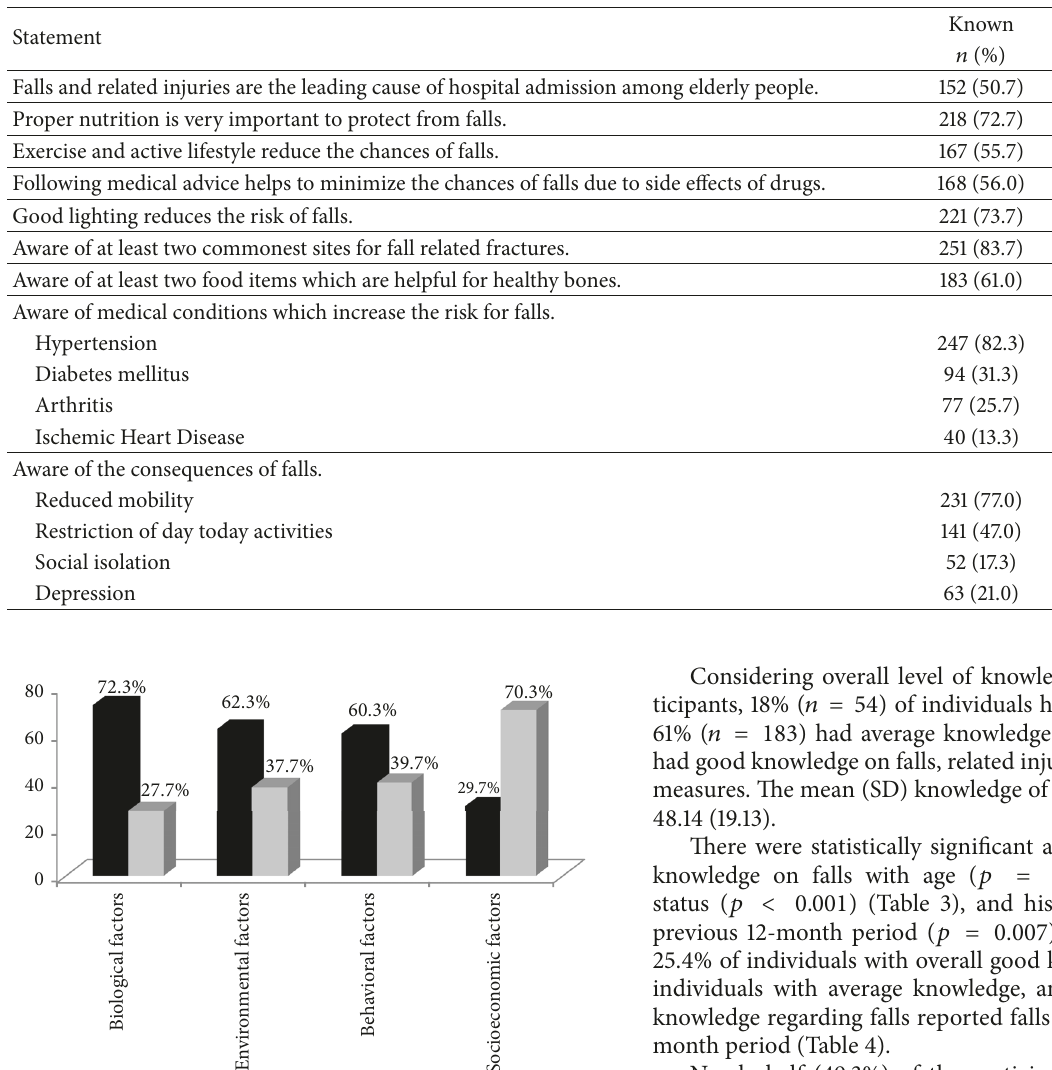
Table 2: Statements that evaluate the knowledge on falls ( 𝑛 = 300 ).